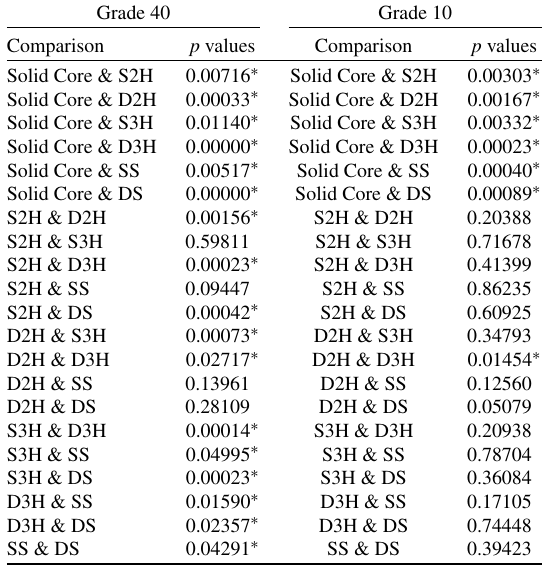
Table 2 Statistical comparison of pullout test results for different designs